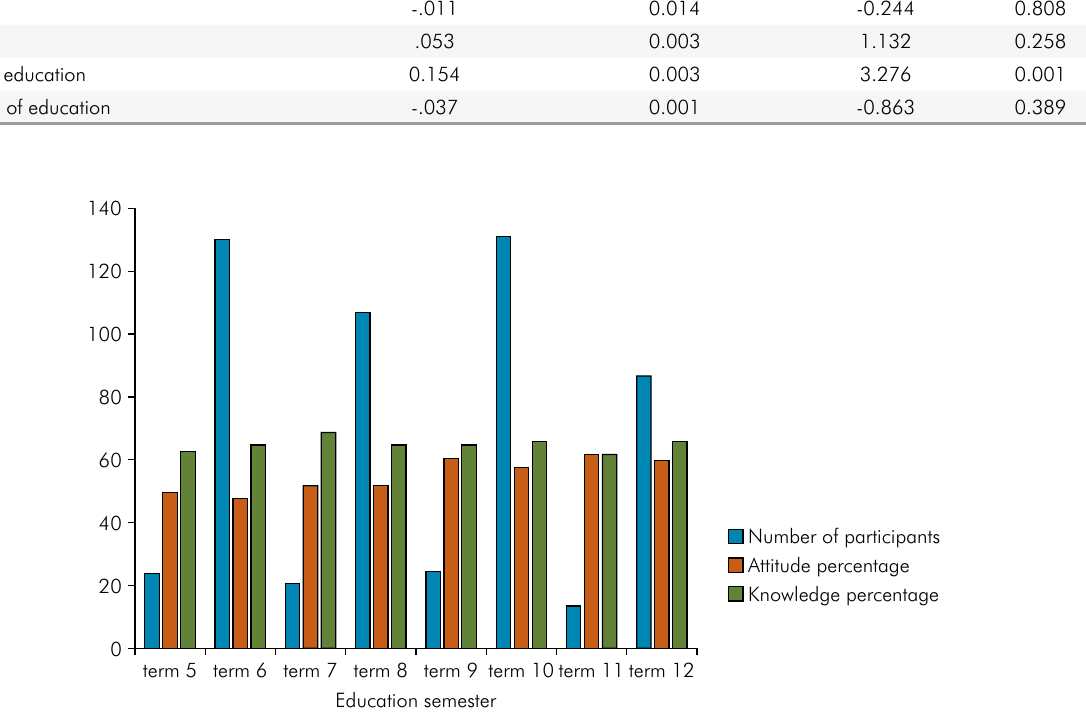
Figure 1. The distribution of students’ cooperation, level of knowledge, and attitude according to the level of